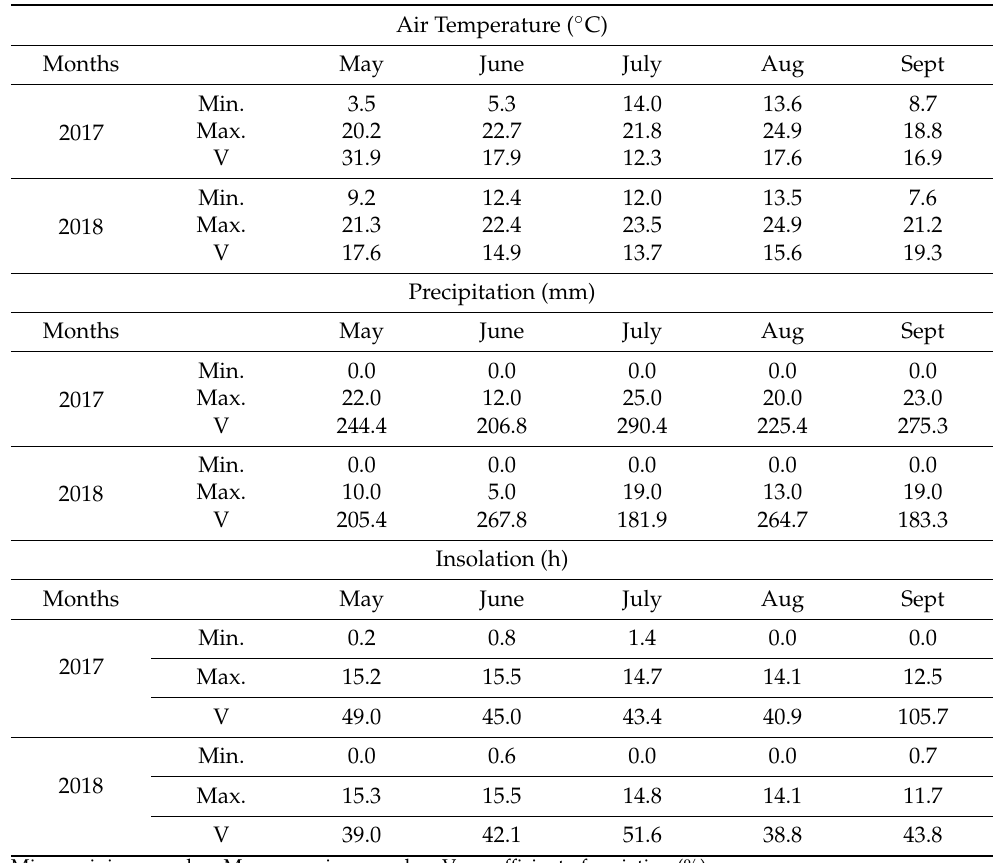
Table 3. Minimum and maximum values and coefficient of variation for air temperature, atmospheric precipitation and